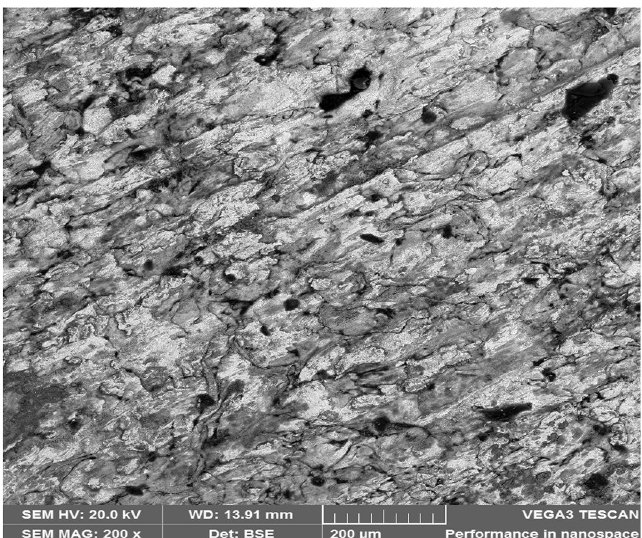
Figure 8. SEM microstructure of As-received grey cast iron.